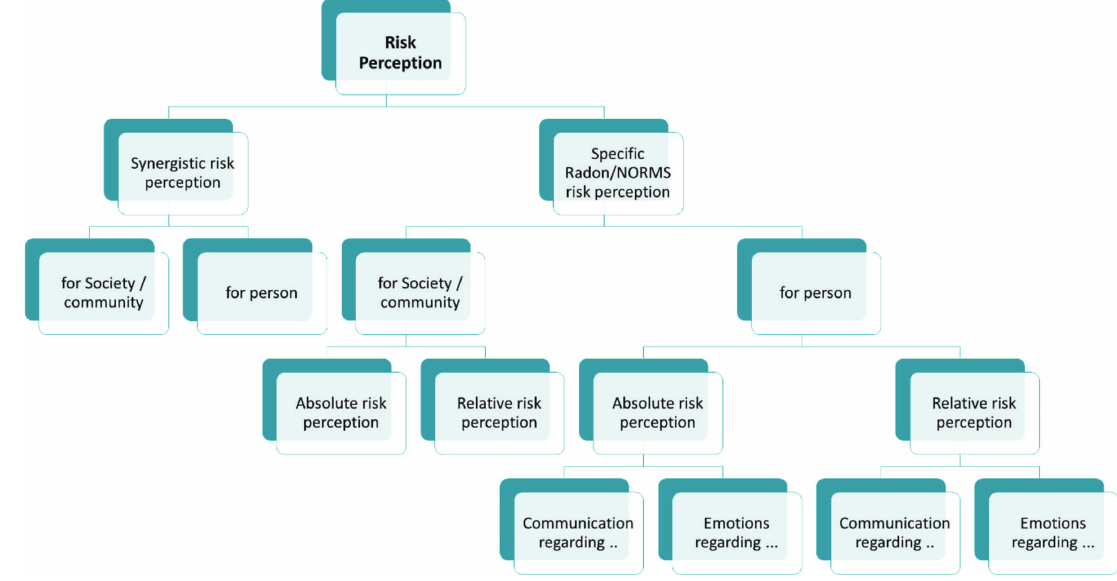
Fig. 6. Systematic overview of Radon/NORM risk